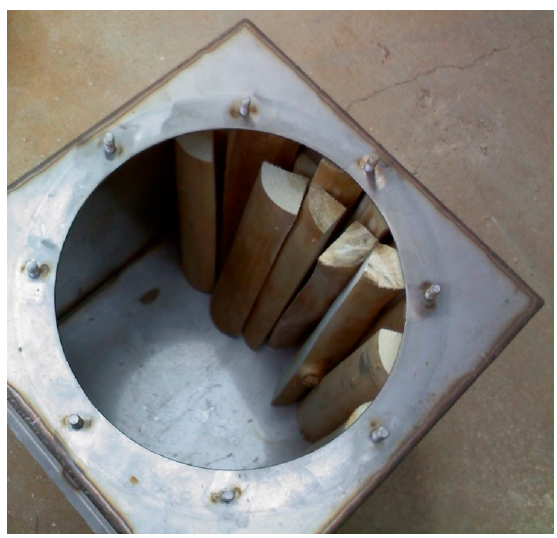
Figure 2. Loading the carbonization chamber with dried wood pieces.